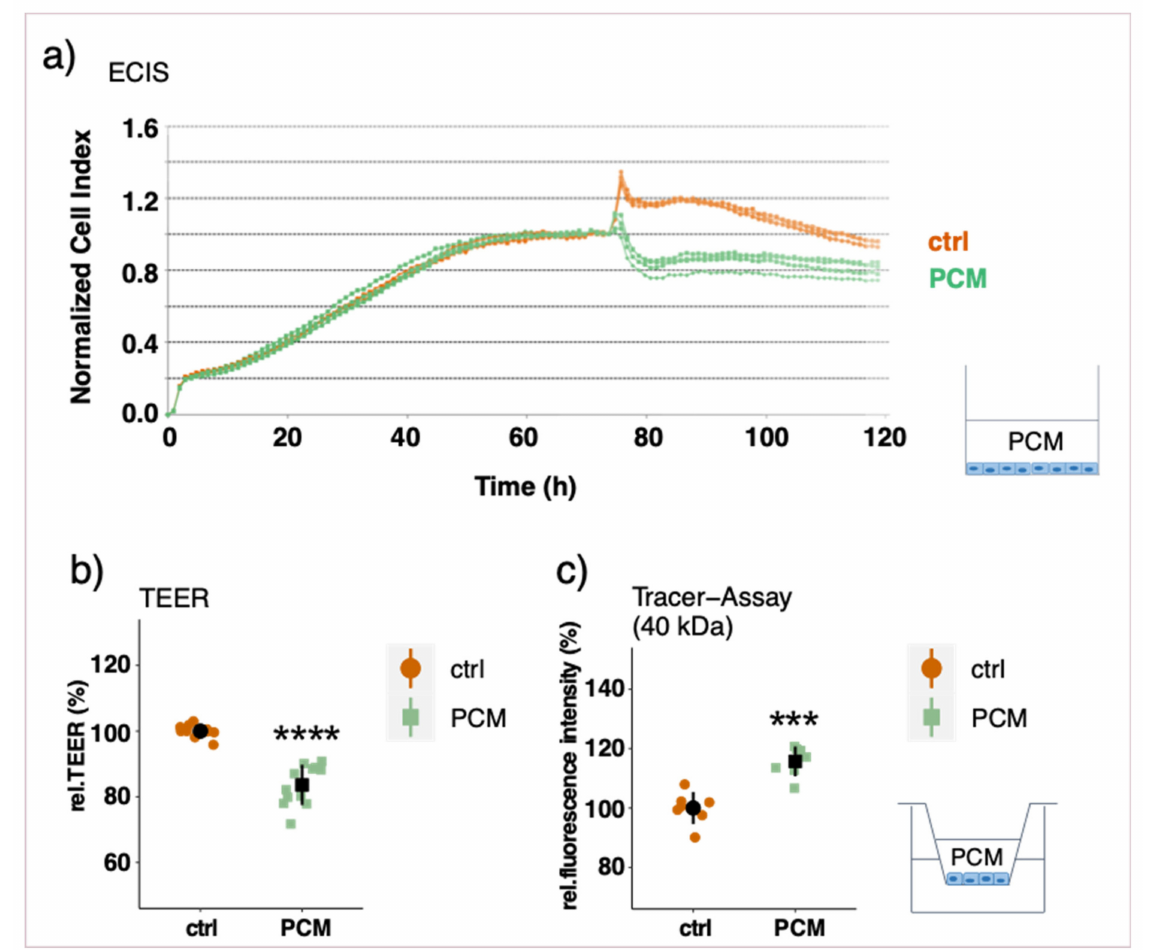
Figure 5. Measurements of endothelial barrier function after apical PCM treatment of an EC monolayer. ECs were cultured in eplates ( a ) or on transwell inserts ( b , c ). After a stable barrier function was established (6–7 days), PCM was added to the apical side for 24 h. Representative real-time ECIS measurements with the xCELLigence system ( a ), relative trans- endothelial electric resistance (TEER) measurements with a CellZcope instrument ( b ) and macromolecular tracer assays with FITC-labeled dextran of 40 kDa (representative also for 4 kDa) ( c ). Experiments were performed at least three times in triplicates and data represent mean ± sd. *** p < 0.001, **** p <